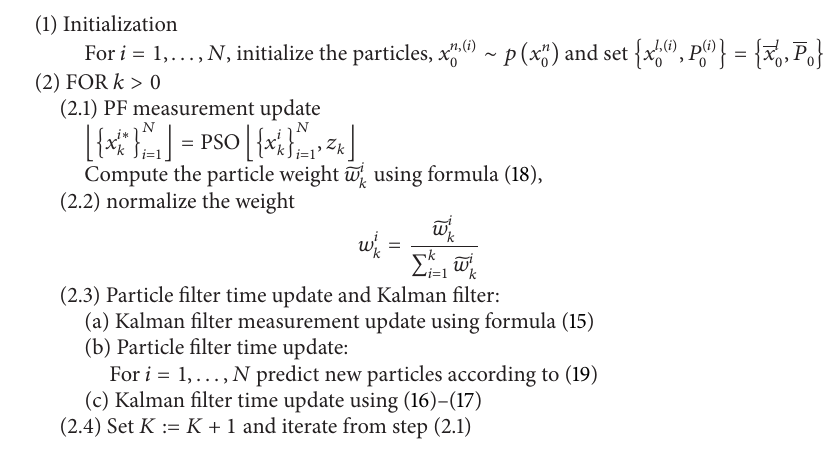
Pseudocode 3: The PSO optimized Rao-Blackwellized particle filter.